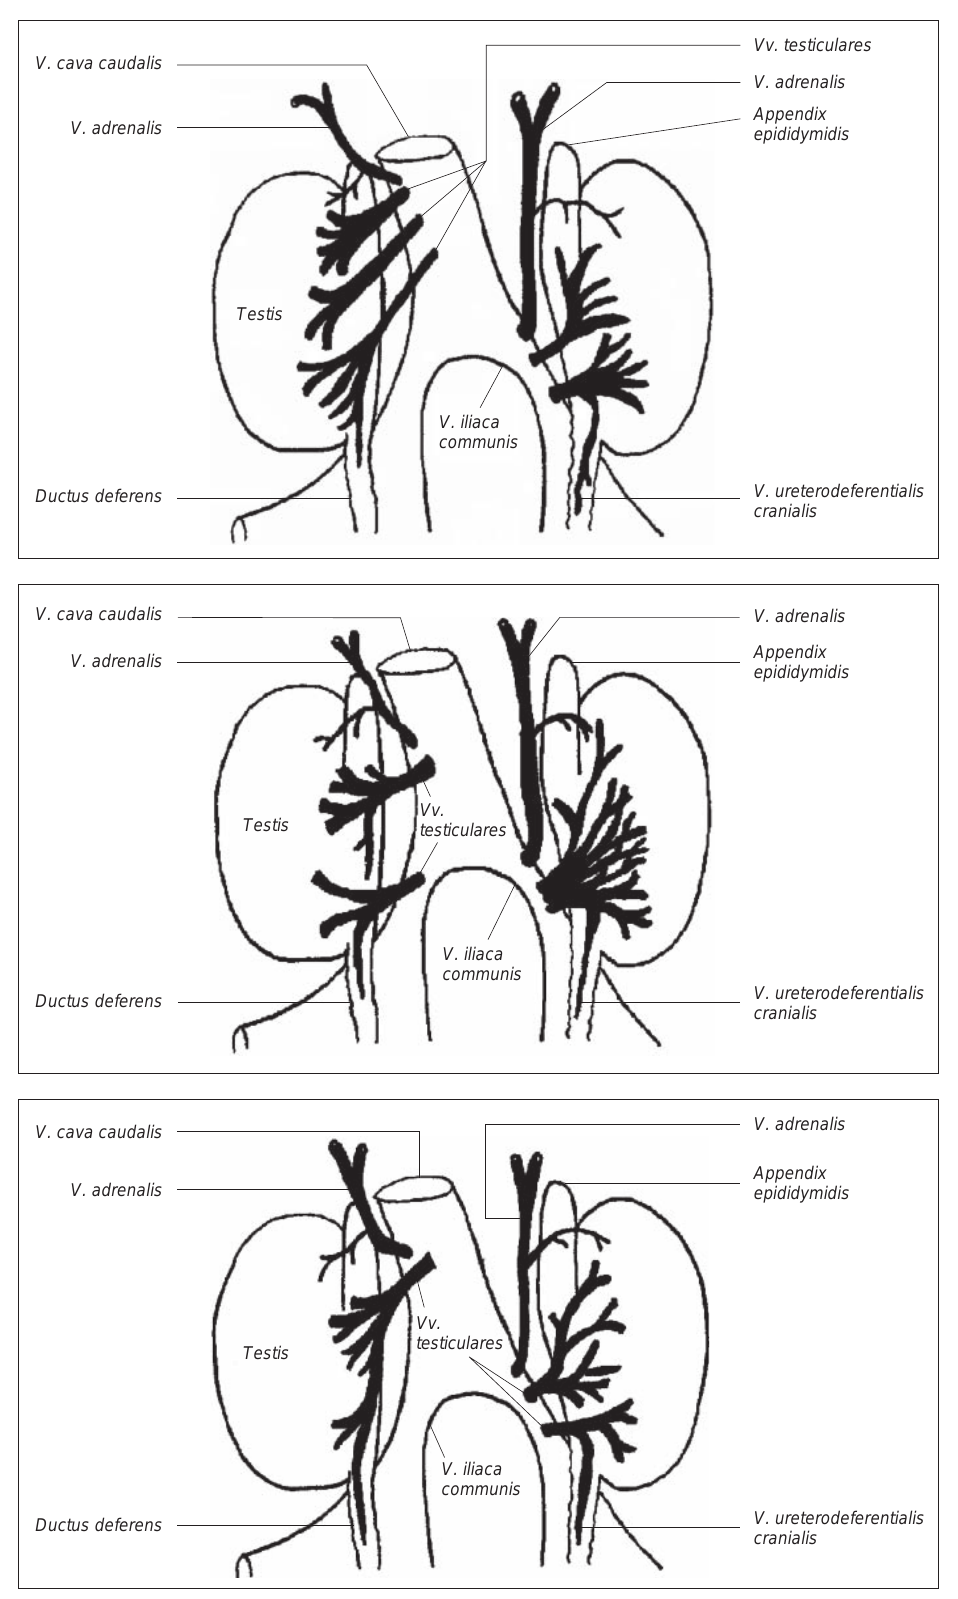
FIG. 2A–C Diagramatic sketches showing, in ventral view, the main variations of the testicular veins in respect of their number and